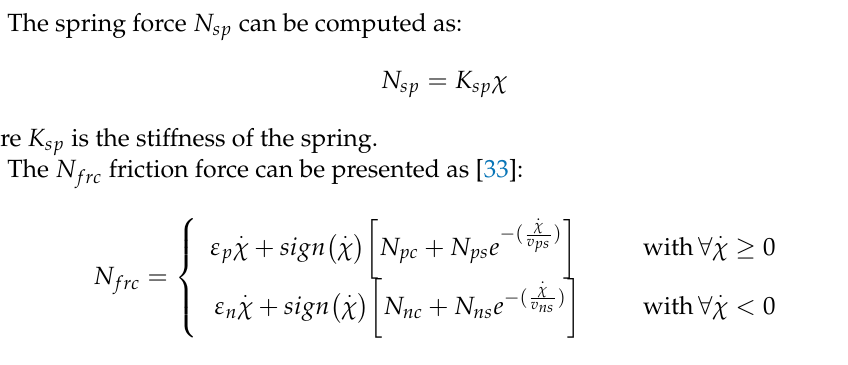
Figure 1. Block diagram of an electro-hydraulic actuator EHA system